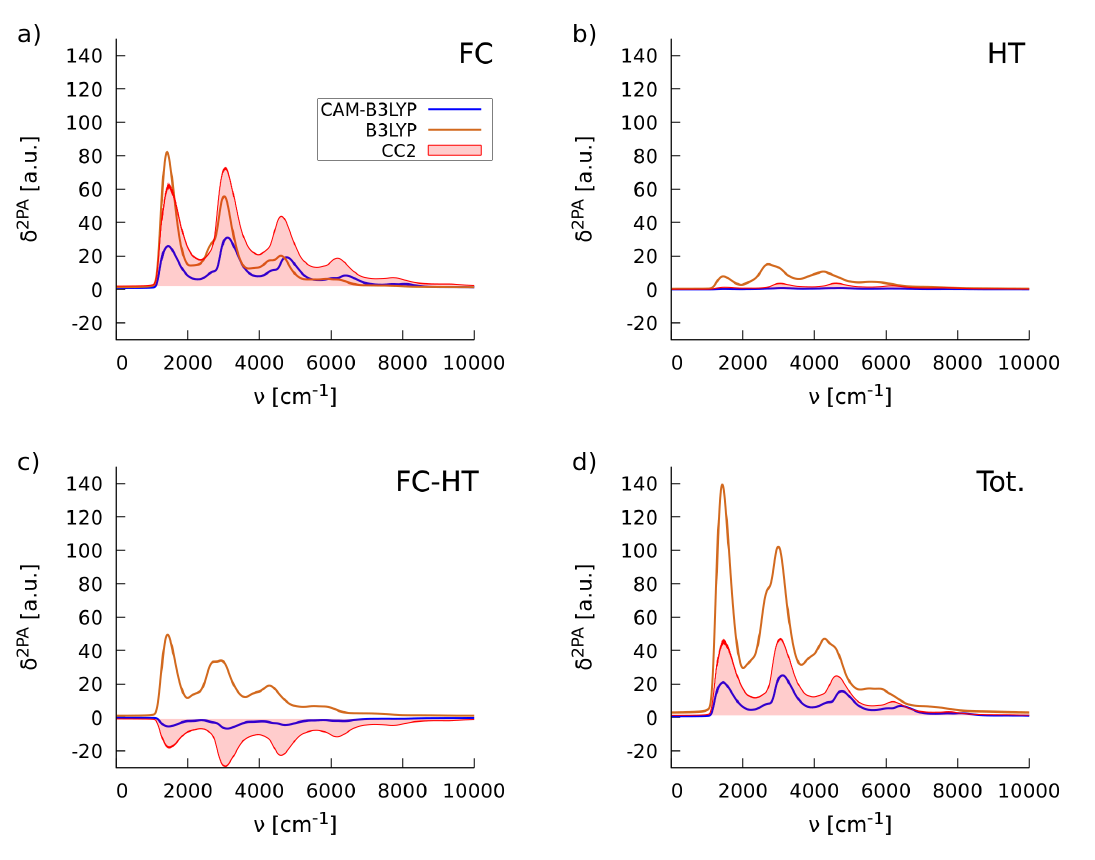
Figure 4. The simulated vibronic two-photon absorption spectra of the C-1 molecule in vacuo with the B3LYP and CAM-B3LYP functionals and the CC2 method including the Franck–Condon ( a ), Herzberg-Teller ( b ) and Franck–Condon/Herzberg–Teller ( c ) contributions; and the total 2PA spectrum ( d